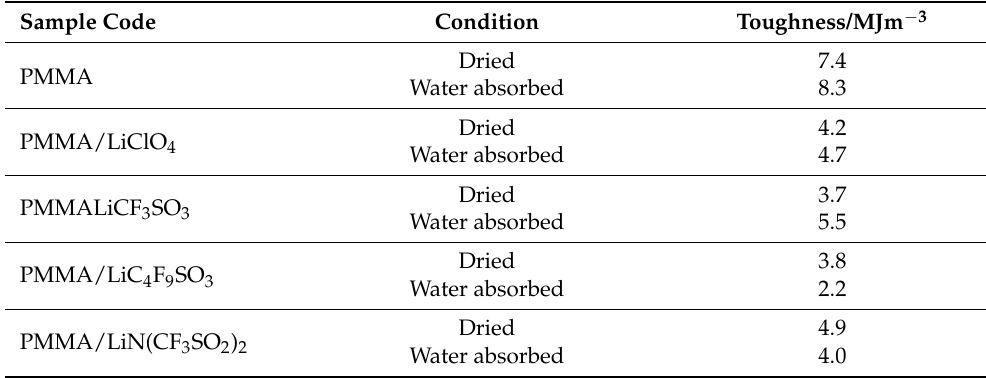
Table 3. Toughness values of dried samples and water-absorbed samples PMMA and PMMA doped with LFMS, LFBS, LiClO 4 , and LiN(CF 3 SO 2 ) 2 at a molar concentration of